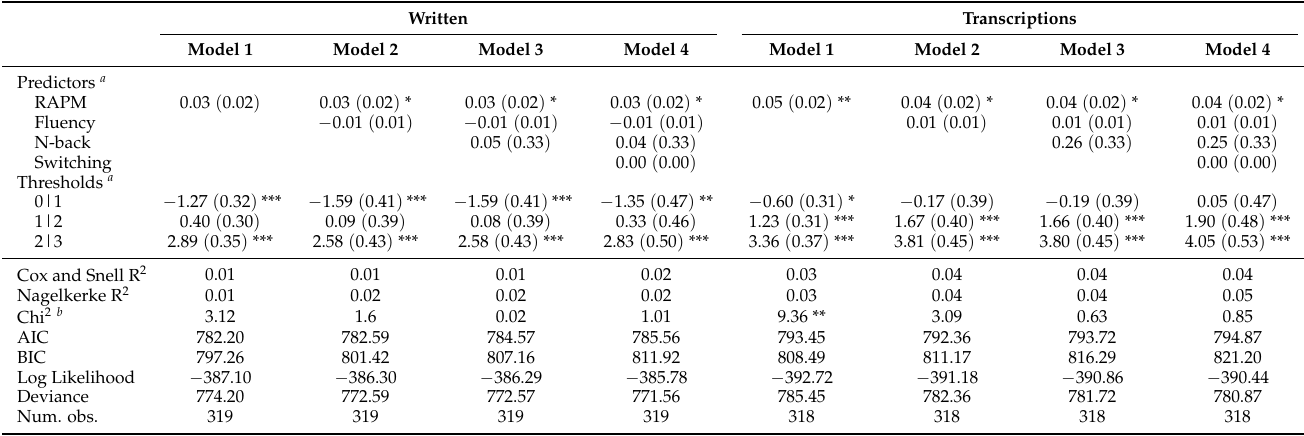
Table 3. Ordinal logistic regression model parameters and comparisons.